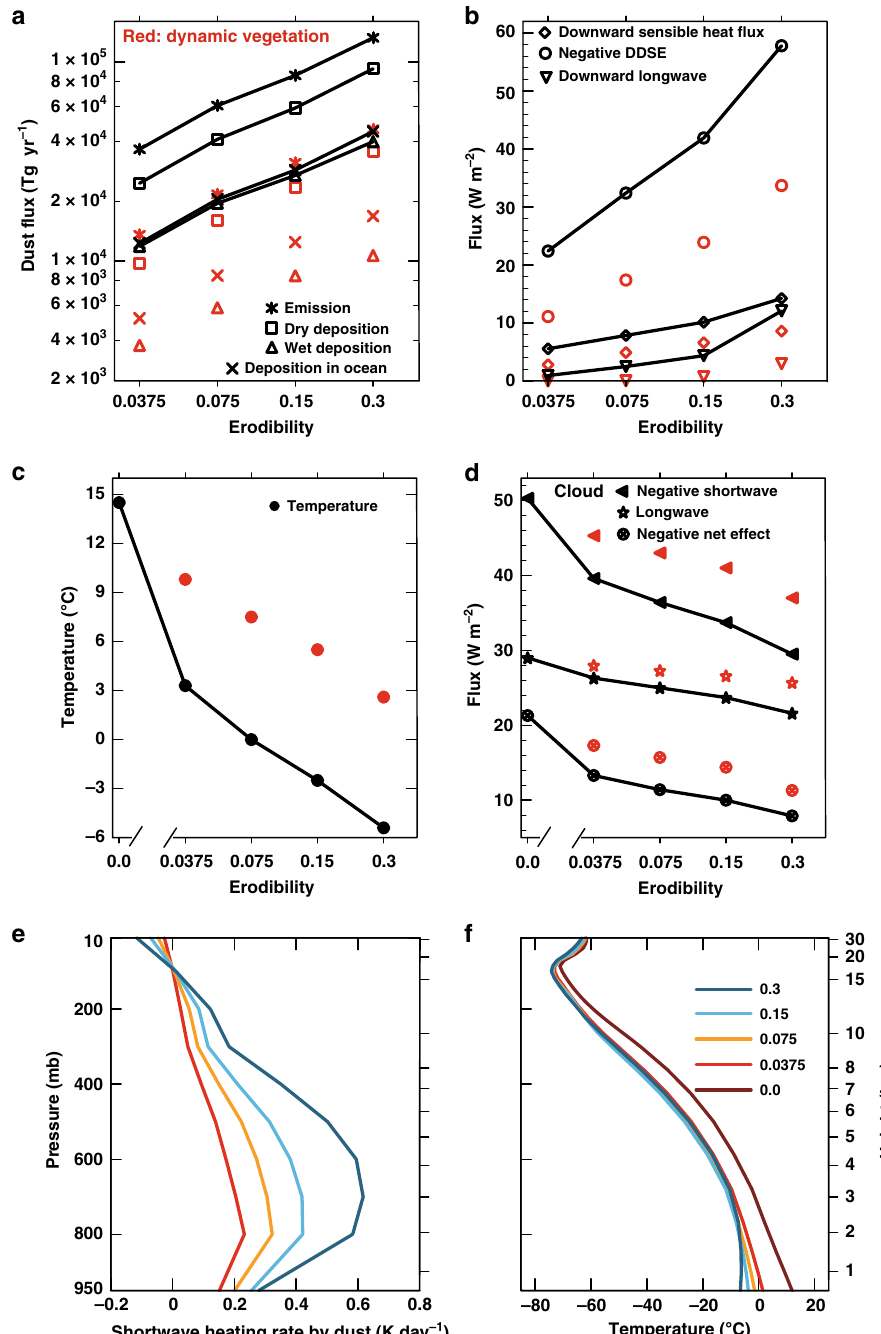
Fig. 2 Variations of global dust, radiative forcings and temperature with surface erodibility. All variables are in global mean except in ( a ) where the global sum is shown. a The surface emission, dry and wet deposition onto the surface, and total (dry + wet) deposition into the ocean, of dust every year (unit: Tg yr − 1 ); b Dust Direct Shortwave Effect (DDSE) which represents the reduction of solar radiation received at the surface, anomalous downward sensible heat fl ux and longwave radiative fl uxes at the surface due to dust (see method section for how they are diagnosed); c Annual mean surface temperature; d Longwave, shortwave and net cloud radiative forcings, where the latter two are negative but their absolute values are shown for the sake of convenience; e Heating rate of the atmosphere by dust; f Vertical temperature pro fi les of the atmosphere. The red markers in ( a – d ) are values for the cases with dynamic vegetation turned on. Note that both the horizontal and vertical axes in ( a ) are in base-10 logarithmic scale, so the lines in this panel indicate linear relationship. The x -axes for erodibility (dimensionless variable) in panels ( b – d ) are in logarithmic scale except the zero erodibility